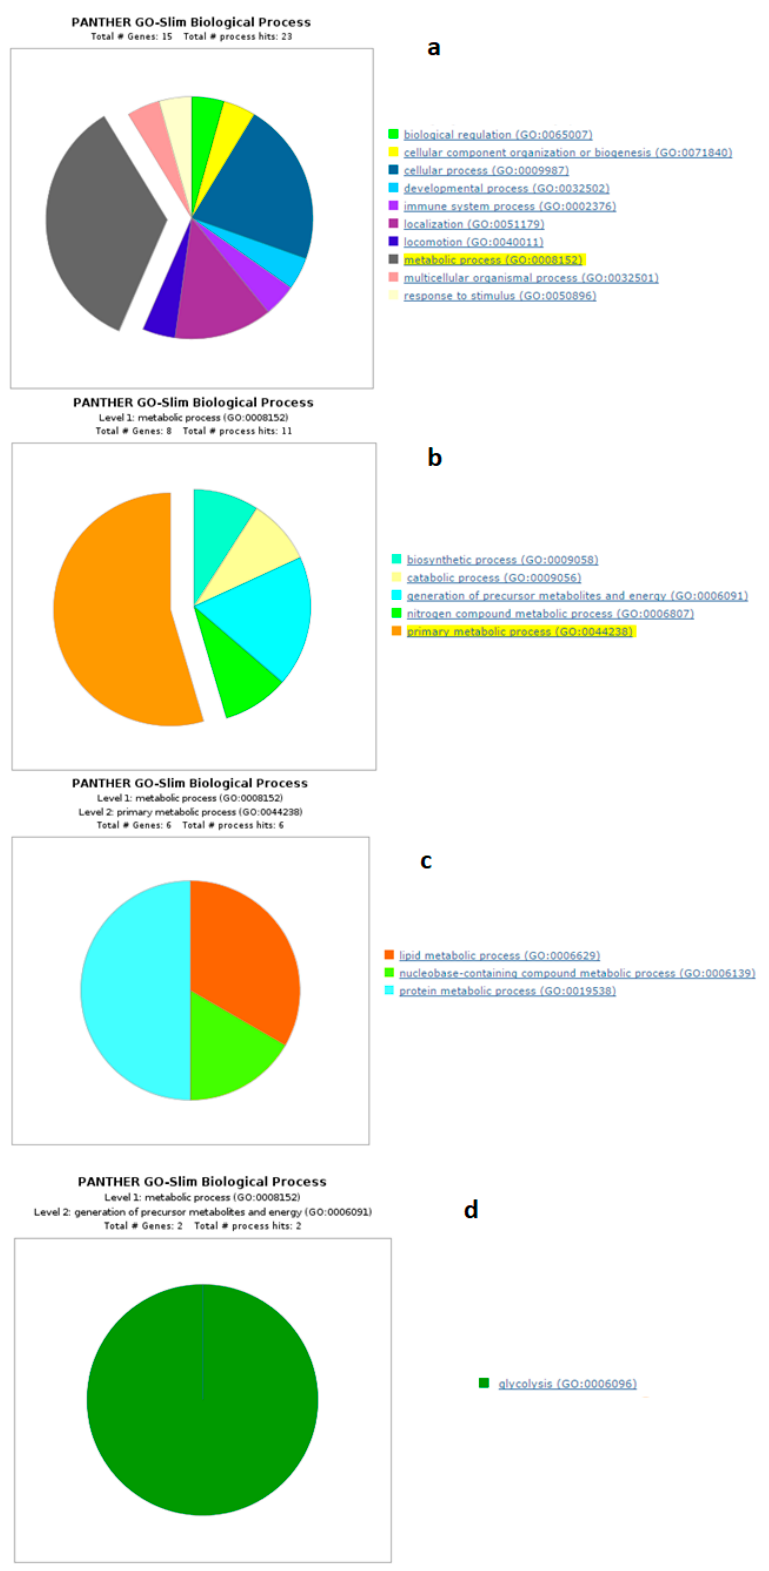
Figure 8. Functional classification of underrepresented proteins of all time points between sNEB and lNEB with the enrichment of most represented processes up to the primary metabolic process. ( a ) Biological process, ( b ) metabolic process, ( c ) primary metabolic process ( d ) generation of precursor metabolites and energy.